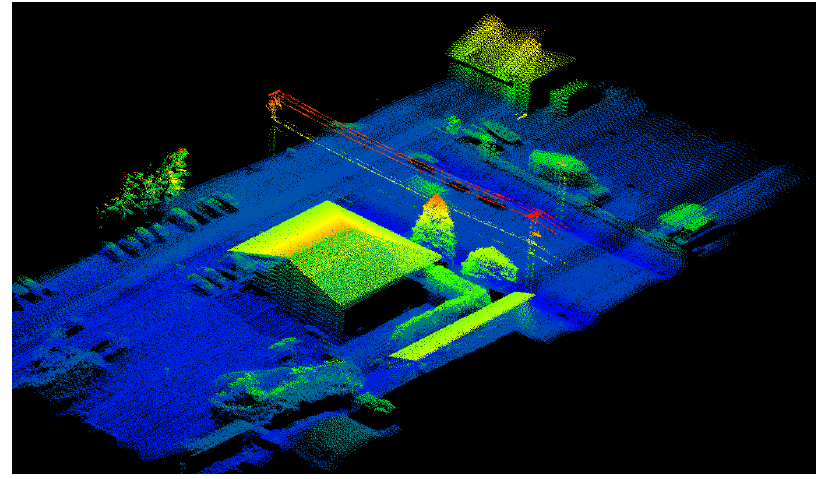
Figure 7. Point cloud of natural surface with the presence of